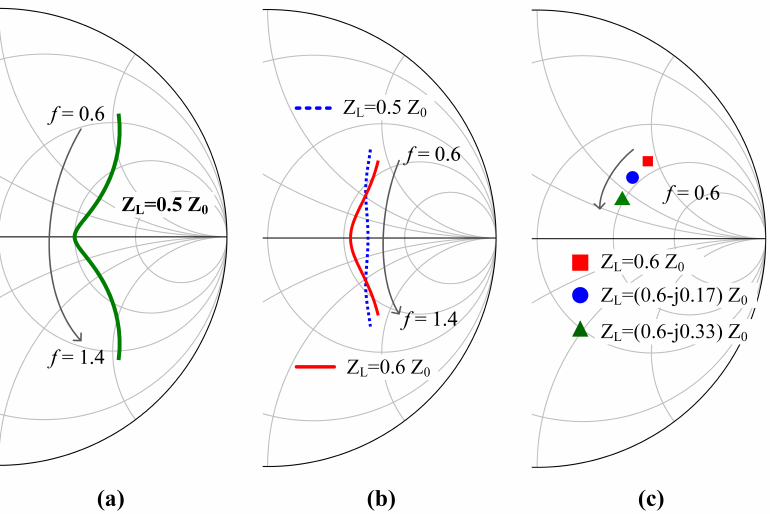
Figure 2. Calculated Z CB of ( a ) the traditional DPA and ( b ) the proposed DPA with modified combiner in the normalized frequency band of 0.6–1.4. ( c ) Calculated Z CB of the proposed DPA with complex combining impedance when f =